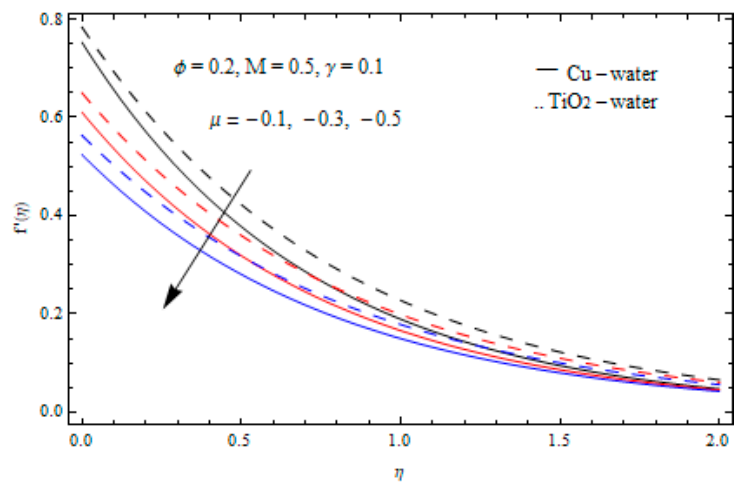
μ on velocity of Cu-water and TiO 2 -water nanofluids. Figure 7. Effect of second slip µ on velocity of Cu-water and TiO